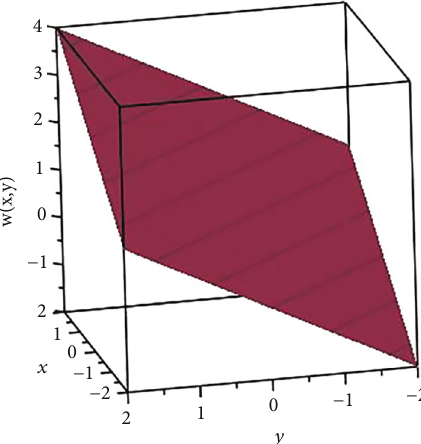
Figure 17: 3D complex plot of (61) for α = 1 and m